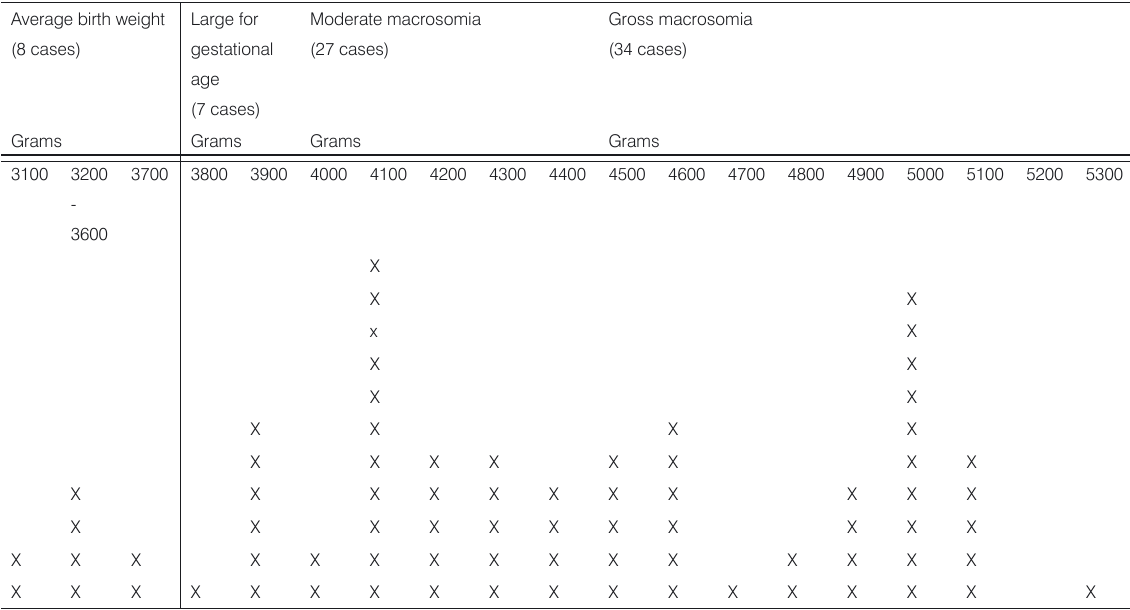
Table 4. Birth weights in 76 cases of shoulder dystocia related fetal neurological injuries that followed omission of indicated screening for and/or inadequate treatment of